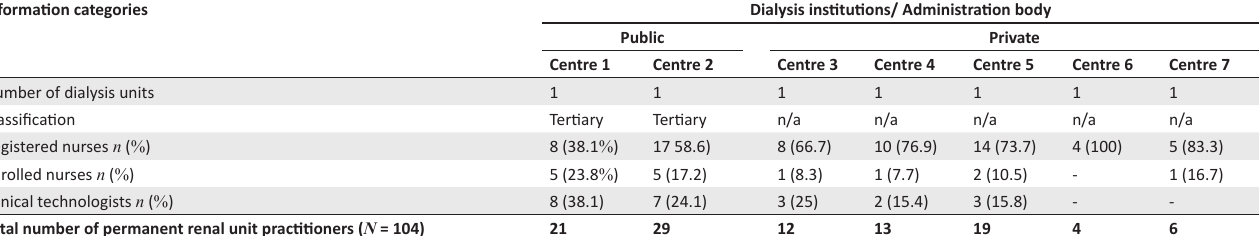
TABLE 1: Dialysis units included in the study. Information